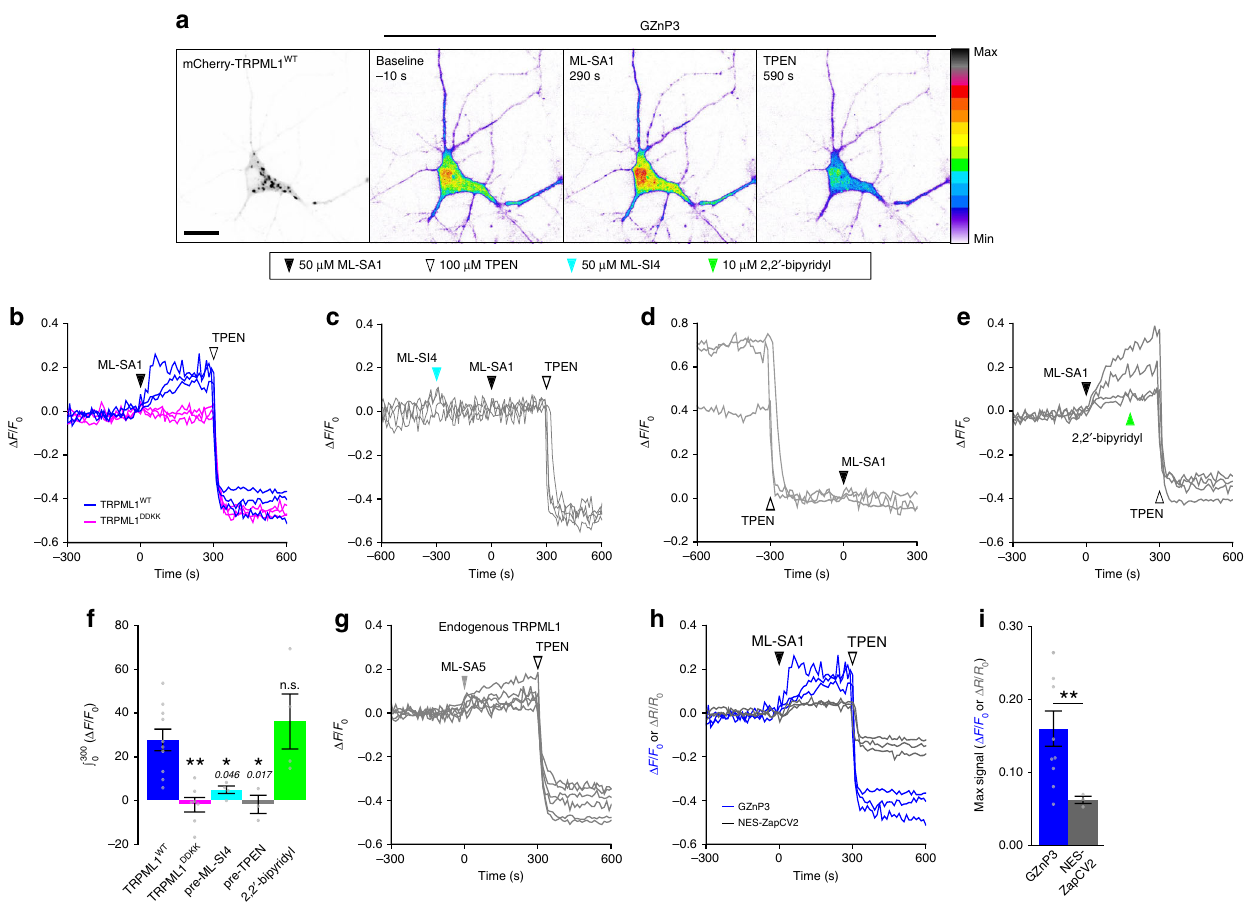
Fig. 3 Activation of TRPML1 evokes cytosolic Zn 2 + signals in neurons. a Representative micrographs of primary rat hippocampal neurons co-expressing mCherry-TRPML1 WT (left) and GZnP3 at baseline after ML-SA1 addition, or after TPEN treatment. Pseudocolor shows GZnP3 fl uorescent intensity indicated by calibration bar (far right; minimum = white, maximum = black). Scale bar = 20 µ m. b Representative traces of neurons co-expressing GZnP3 and mCherry-TRPML1 WT (blue) or mCherry-TRPML1 DDKK (magenta). Neurons were treated with ML-SA1 at 0 s and TPEN at 300 s. c Representative traces of neurons co-expressing GZnP3 and mCherry-TRPML1 pretreated with ML-SI4 at -300 s, ML-SA1 at 0 s, and TPEN at 300 s. d Representative traces of neurons co-expressing GZnP3 and mCherry-TRPML1 pretreated with TPEN at -300 s and ML-SA1 at 0 s. e Representative traces of neurons co- expressing GZnP3 and mCherry-TRPML1 treated with ML-SA1 at 0 sec, 2,2 ’ -bipyridyl (Fe 2 + chelator) at 180 s, and TPEN at 300 s. f Mean integrated GZnP3 signal (±s.e.m.) within 300 s after ML-SA1 addition for TRPML1 WT (blue, n = 10), TRPML1 DDKK (magenta, n = 7), inhibitor pretreatment (pre-ML- SI4, cyan, n = 4), TPEN pretreatment (pre-TPEN, gray, n = 3), and Fe 2 + chelation (2,2 ’ -bipyridyl, green, n = 4). One-way ANOVA with Dunnett ’ s multiple comparison to TRPML1 WT . g Representative traces of neurons co-expressing GZnP3 and NES-mCherry treated with 10 – 20 µ M ML-SA5 at 0 s (gray arrow) and TPEN at 300 s. h Representative traces of neurons co-expressing mCherry-TRPML1 and either GZnP3 (blue) or NES-ZapCV2 (gray) treated as in b . i Mean maximum sensor signal (±s.e.m.) within 300 s after ML-SA1 addition for GZnP3 (blue, n = 10) and NES-ZapCV2 (gray, n = 3). Student ’ s one- tailed t -test. ** p < 0.01, * p < 0.05. n.s., not signi fi cant. p- values displayed in italics above corresponding comparisons where applicable. 50 µ M ML-SA1 (black arrow), 100 µ M TPEN (white arrow), 50 µ M ML-SI4 (cyan arrow), 10 µ M 2,2 ’ -bipyridyl (green arrow). Source data are provided as a Source Data fi